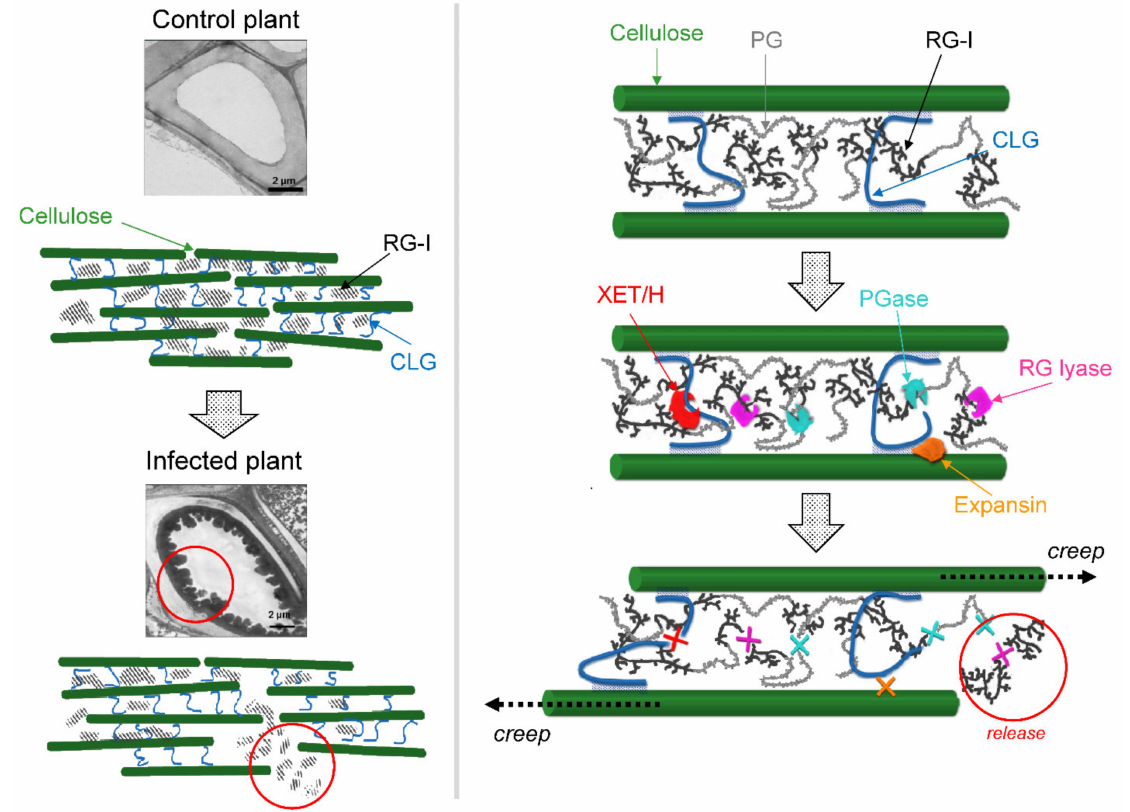
Figure 2. Hypothetical scheme of plant-mediated plant cell wall loosening that leads to the release of rhamnogalacturonan I (RG-I) fragments into the vessel lumen as a result of plant responses to Pectobacterium atrosepticum . Left-hand side, top : photo of the vessel of the control plant and scheme of the intact cell wall structure; bottom : photo of the vessel of the infected plant showing the release of RG-I (red circle) and scheme for plant cell wall modification associated with the release of RG-I (red circle). Right-hand side : scheme of events related to the release of RG-I at the scale of one pair of cellulose microfibrils. Expansins and xyloglucan endo-transglycosylases / hydrolases (XTHs) acting towards cross-linking glycans (CLGs) provide polymer creep and cell wall loosening, while polygalacturonases (PGases) hydrolyzing polygalacturonan (PG) lead to the release of RG-I-rich domains that are further cleaved by RG lyases and galactosidases. Crosses in the bottom panel point to the bonds disrupted by the enzymes or